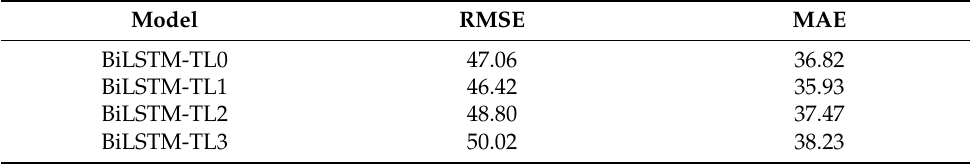
Table 9. Comparison of prediction errors of transfer learning